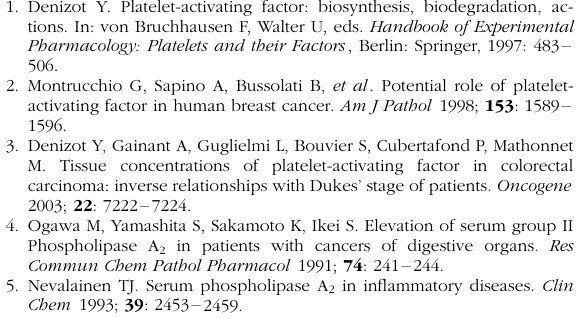
FIG. 1. Blood PAF (A), plasma AHA (B) and soluble PLA 2 (C) levels in colorectal cancer patients. Mean 9 / standard error of the mean of 29 colorectal cancer patients and 20 healthy controls. Differences between groups were assessed using the Mann (cid:1) / Whitney